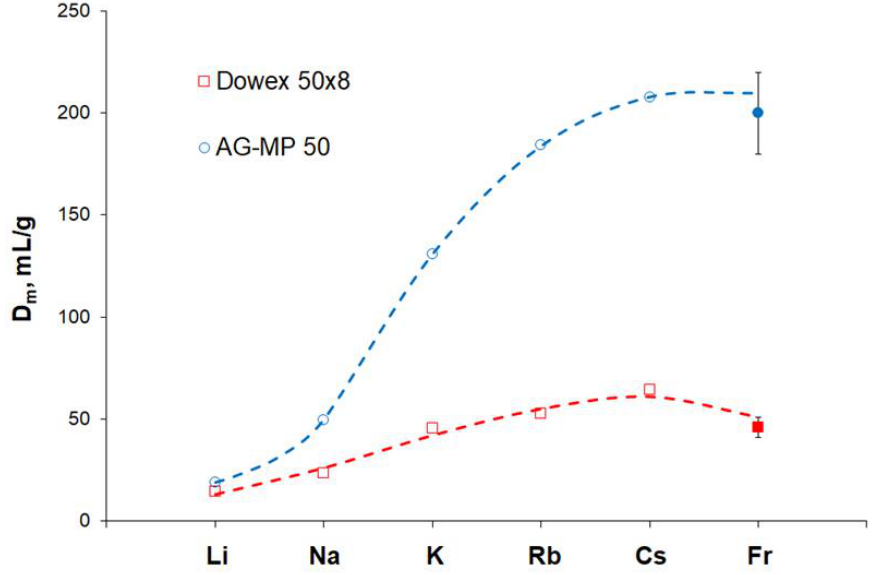
Figure 6. The mass distribution ratios D m , mg/mL, of alkali metal ions upon sorption onto Dowex 50 × 8 and AG MP-50 from 0.25 M nitric or hydrochloric acid. Literature data [28,38] are shown by empty circles and squares.